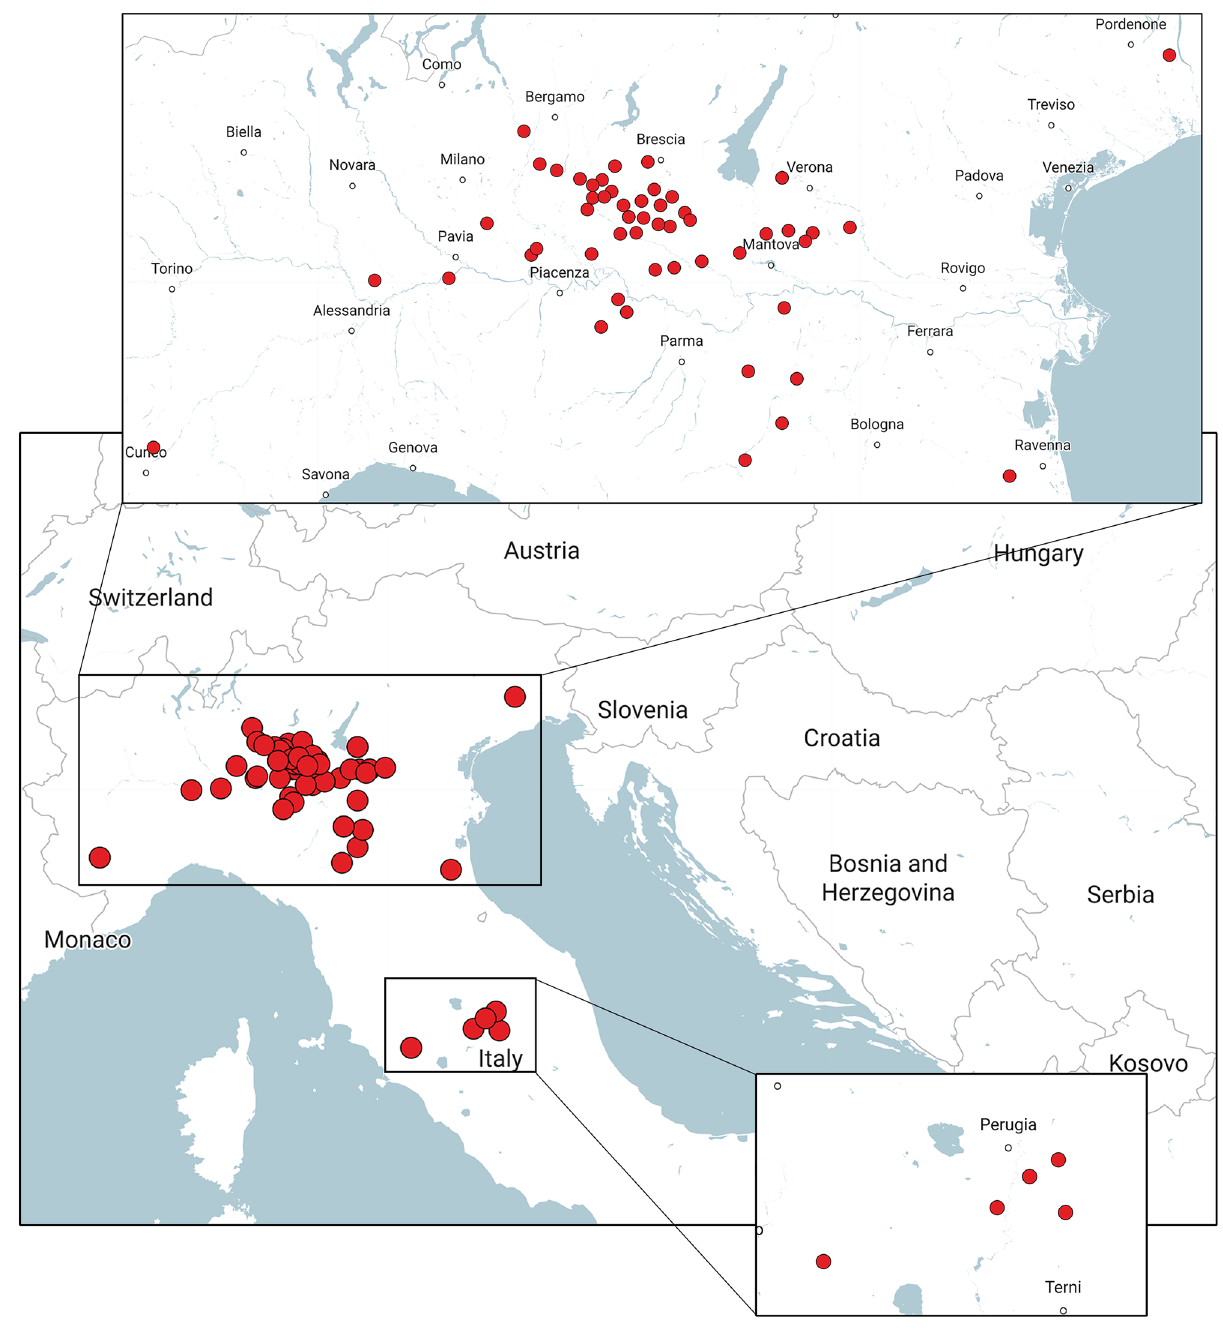
Figure 1. Geographic origin of EMCV recent isolates. The map shows the exact location of samples’ collection. The main box is an overall picture of the sampling area involving Northern and Central Italy; two boxes display magnifications of affected area. The major study area, big square, included almost all of the Po Valley, primarily Lombardy, Emilia-Romagna and Veneto, even if analysis also considered some samples from Piedmont (Cuneo, in the south-western border of the box) and Friuli Venezia-Giulia (near to Pordenone, in the north-eastern border of the box). Affected Central Italy area, tiny square, was smaller and included a zone between south of Tuscany (close to Grosseto) and Umbria (province of Perugia). Each red dot represents one village where sampling took place. Two or more farms could be located in the same village and indicated by a unique icon. Pictures were generated on-line on https:// it. batch geo.